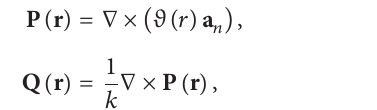
In this paper, the dyadic Green’s function in a cylindrical medium can be represented in terms of cylindrical vector wave eigenfunctions. So, at first we find the vector wave function for each PEC via in the SIW rat-race coupler structure which is excited by coaxial cables and shown in Figure 1. Because of using four coaxial cables instead of microstrip line transitions and a closed form of arms ( 𝜆/4 distance from the coaxial cables), our structure in this paper is of low loss and